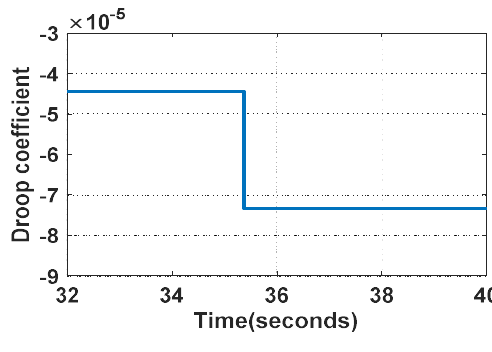
Figure 12. Droop coefficient at DG2.